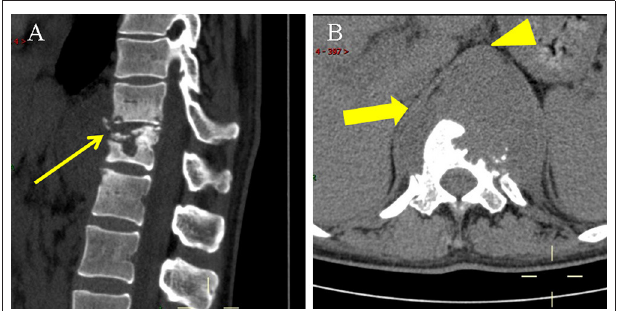
FIGURE 1 | Non-enhanced CT scan on 13 October 2021. (A) Lateral CT scan showed T11-L1 with bone destruction and sequestrums (thin arrow). (B)